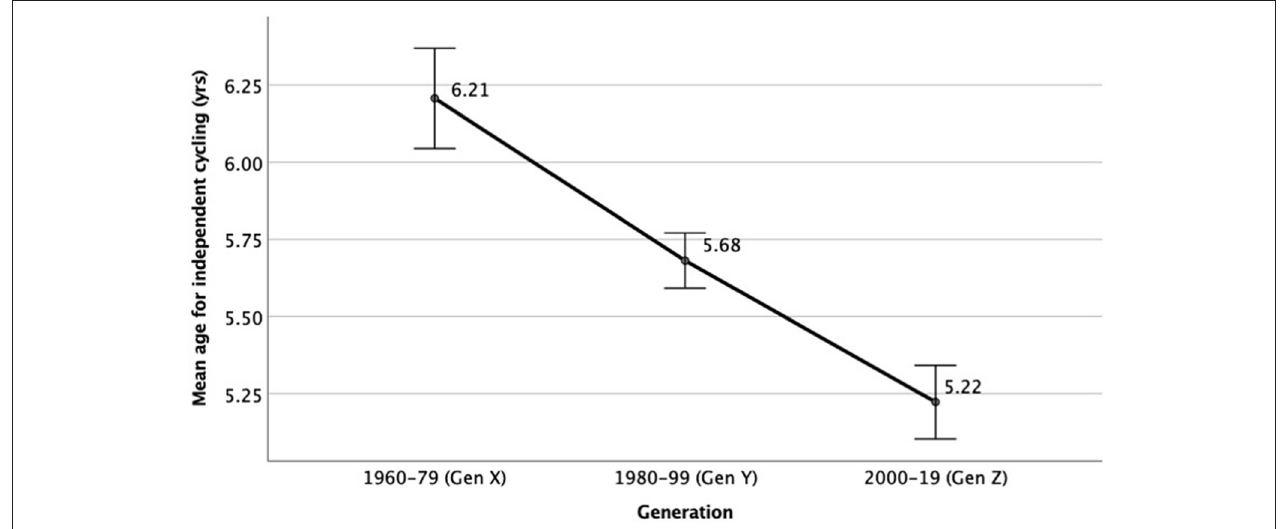
FIGURE 2 | Mean age to learn how to cycle independently by generation. Error bars represent 95% CI. born in 1980–99) ( p < 0.001), as did Generation Y compared